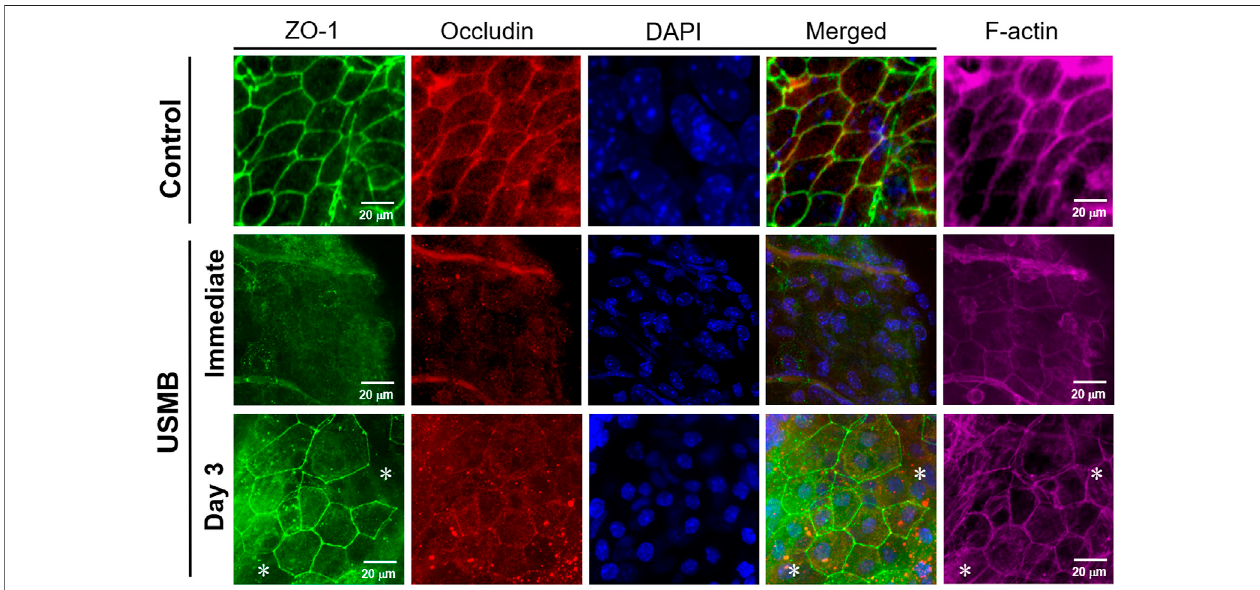
FIGURE 9 | Immunohistochemical detection of the TJ-associated molecules ZO-1 (green), occludin (red), and F-actin (far-red) in the RWM immediately following and 3 days after USMB treatment. The membranes without USMB treatment served as controls. Nuclei were stained with DAPI (blue). Asterisks (*) indicate areas of the cell boundary staining positive for F-actin but negative for ZO-1. USMB, ultrasound microbubble.